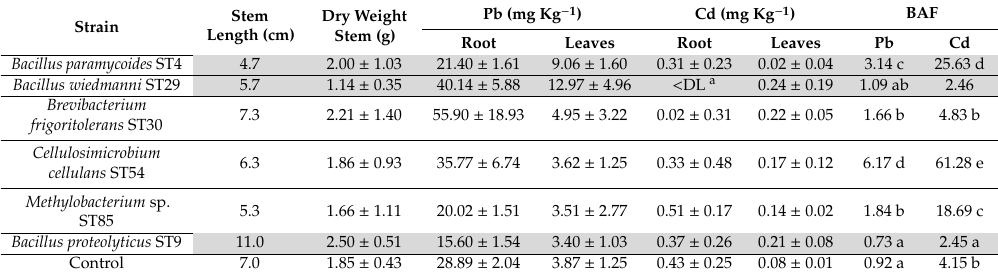
Table 3. Stem length (cm), dry weight (g), concentrations (mg g − 1 ) and Bio-Accumulation Factors (BAF) of Pb and Cd in roots and leaves of H. annuus seedlings inoculated with PGP, Pb-, and Cd-tolerant bacterial strains.